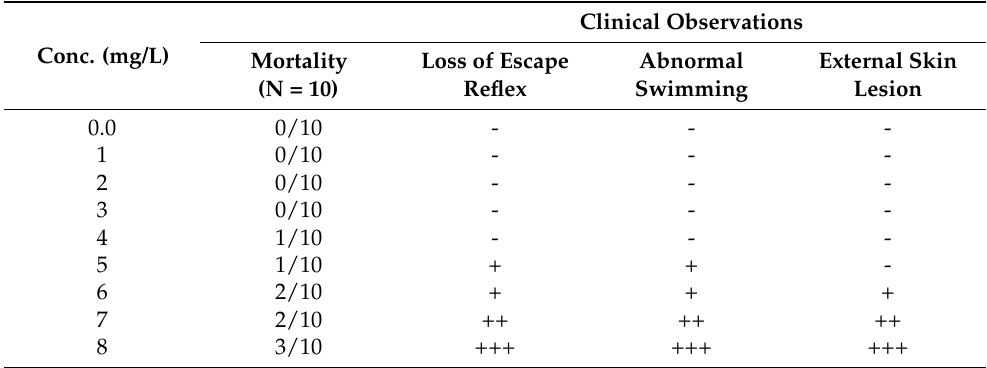
Table 1. Effect of exposure to different concentrations of CWPNC on mortality and clinical observa- tions of O. niloticus for seven